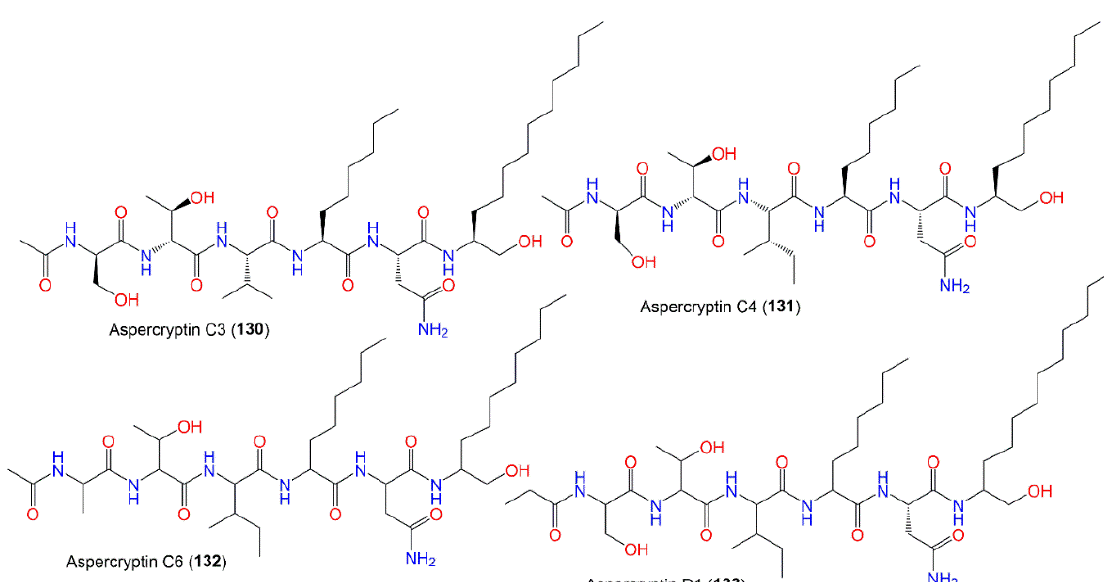
Figure 14. Structures of peptides ( 130 – 133 ).